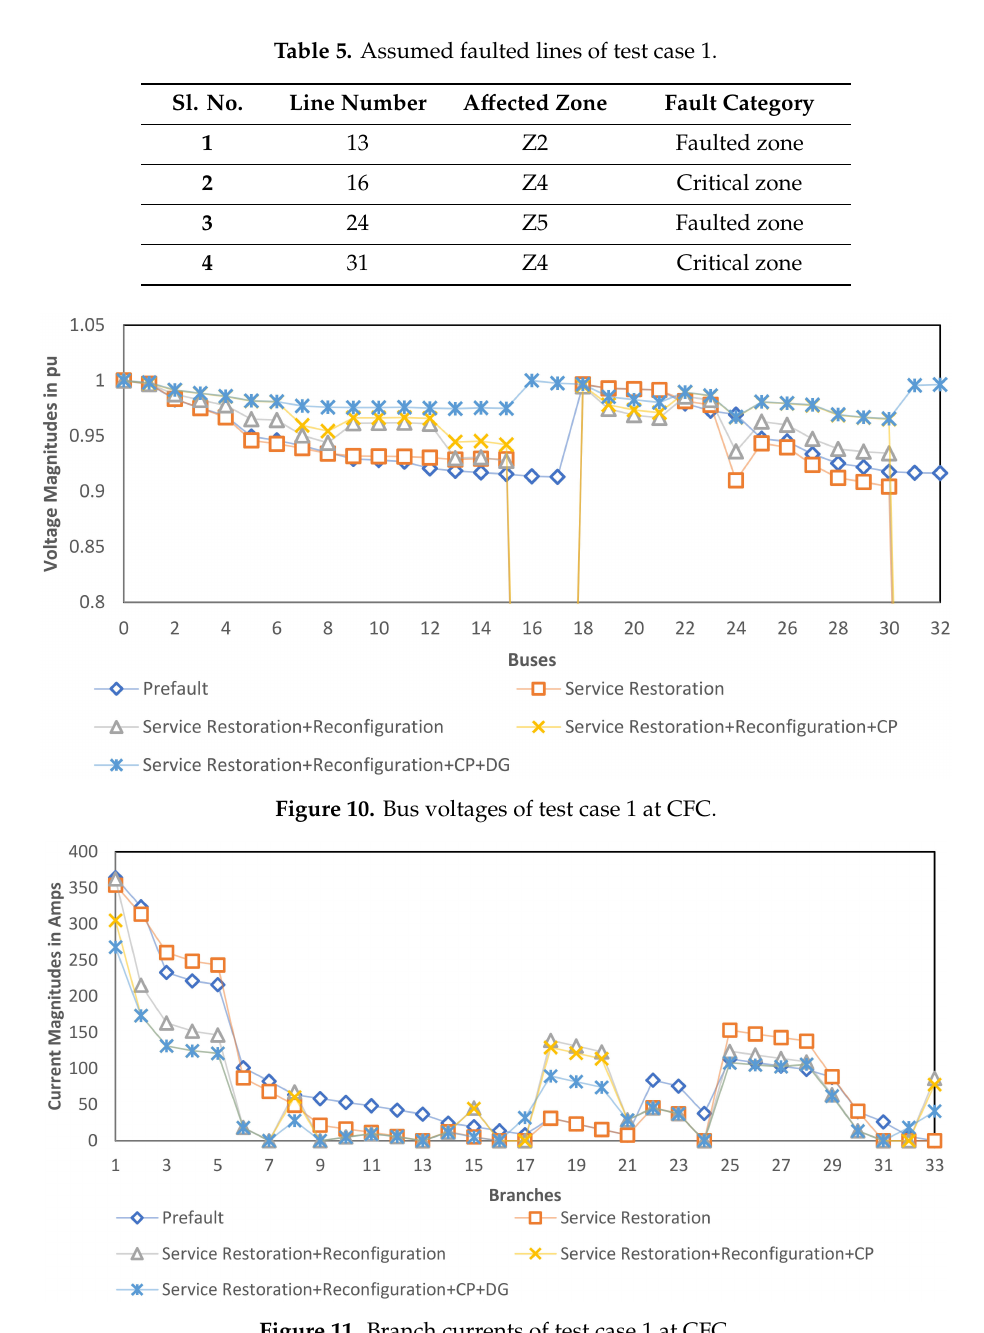
Figure 11. Branch currents of test case 1 at CFC. Table 6. Summary of results for test case 1 under